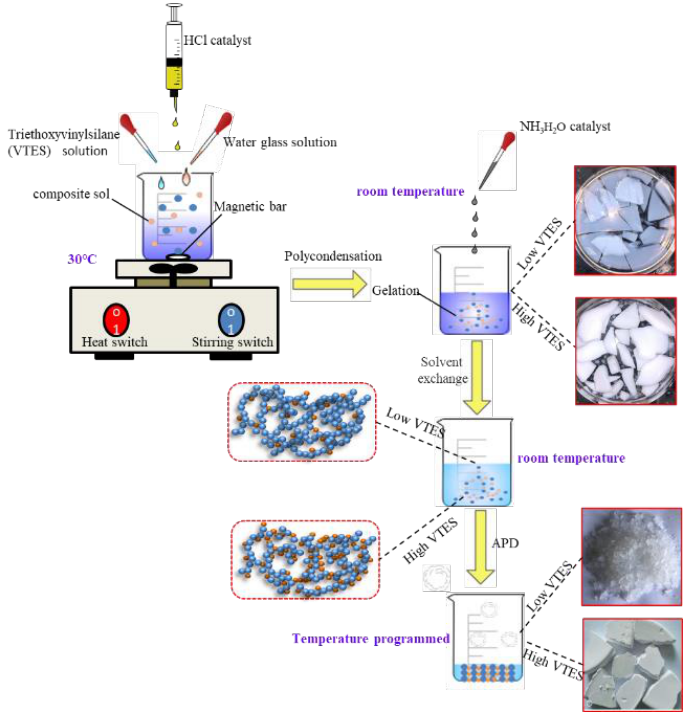
Figure 1. Flowchart demonstrating the preparation of silica aerogel.